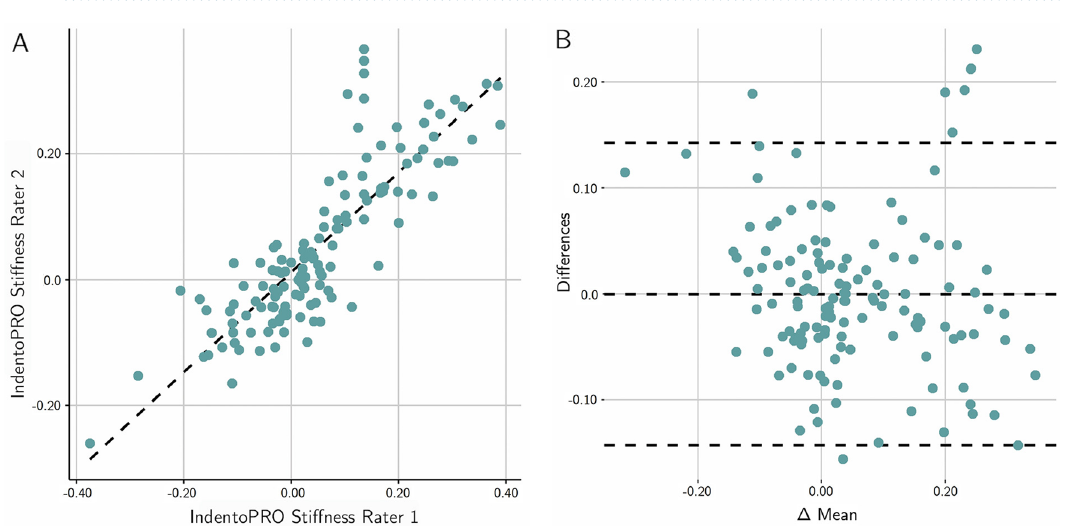
Figure 5. ( A ) Scatter plot of the agreement between the two raters for the IndentoPRO. ( B ) Bland-Altmann plot of the mean differences between the raters. Legend: see Fig. For STCM, correlations ranged from 0.05 to 0.93. Measurements taken with 10 mm penetration depth showed higher correlations (0.70 for changes in CUT, 0.93 for SCT layer, 0.92 for ERS) than measurements with 5 mm penetration depth (0.55, 0.65, and 0.05 respectively). Excellent interrater-variability values were obtained for ERS (0.93), and SCT (0.8) (both related to10 mm penetration depth). MyotonPRO stiffness (N/m) showed the highest correlations throughout all devices, amounting to 0.94 for changes in CUT, 0.98 for SCT and 0.91 for ERS. Interrater reliability for MyotonPRO was excellent throughout all MPTM layers (0.98 for CUT, 0.99 for SCT, 0.94 for ERS). Correlations for IndentoPRO were also large. Highest correlations were found for measurements with a penetration depth of 10 mm (0.90 for stiffness changes in CUT, 0.98 for SCT, 0.97 for ERS). Values for 2 mm penetration depth amounted to 0.88 (cutis), 0.97 (SCT), 0.96 (ERS). Values for 5 mm penetration depth were 0.71 (CUT), 0.97 (SCT), 0.96 (ERS). Correlations for 8 mm penetration depth were calculated at 0.87 (CUT), 0.98 (SCT), and 0.92 (ERS). Interrater reliability was excellent for all penetration depths except CUT at 5 mm penetration depth (ICC = 0.51) and SCT at 10 mm penetration depth (ICC = 0.71). Ultrasound with attached force gauge showed large correlations for SCT (0.80–0.95, for varying pressure levels), and ERS (0.87–0.96). Interrater reliability was excellent for ERS (all applied pressure parameters) and SCT (at 15 kPasc). Interrater reliability for SCT was good for 5 kPasc and 10 kPasc pressures. The detailed results are presented in Table 1.